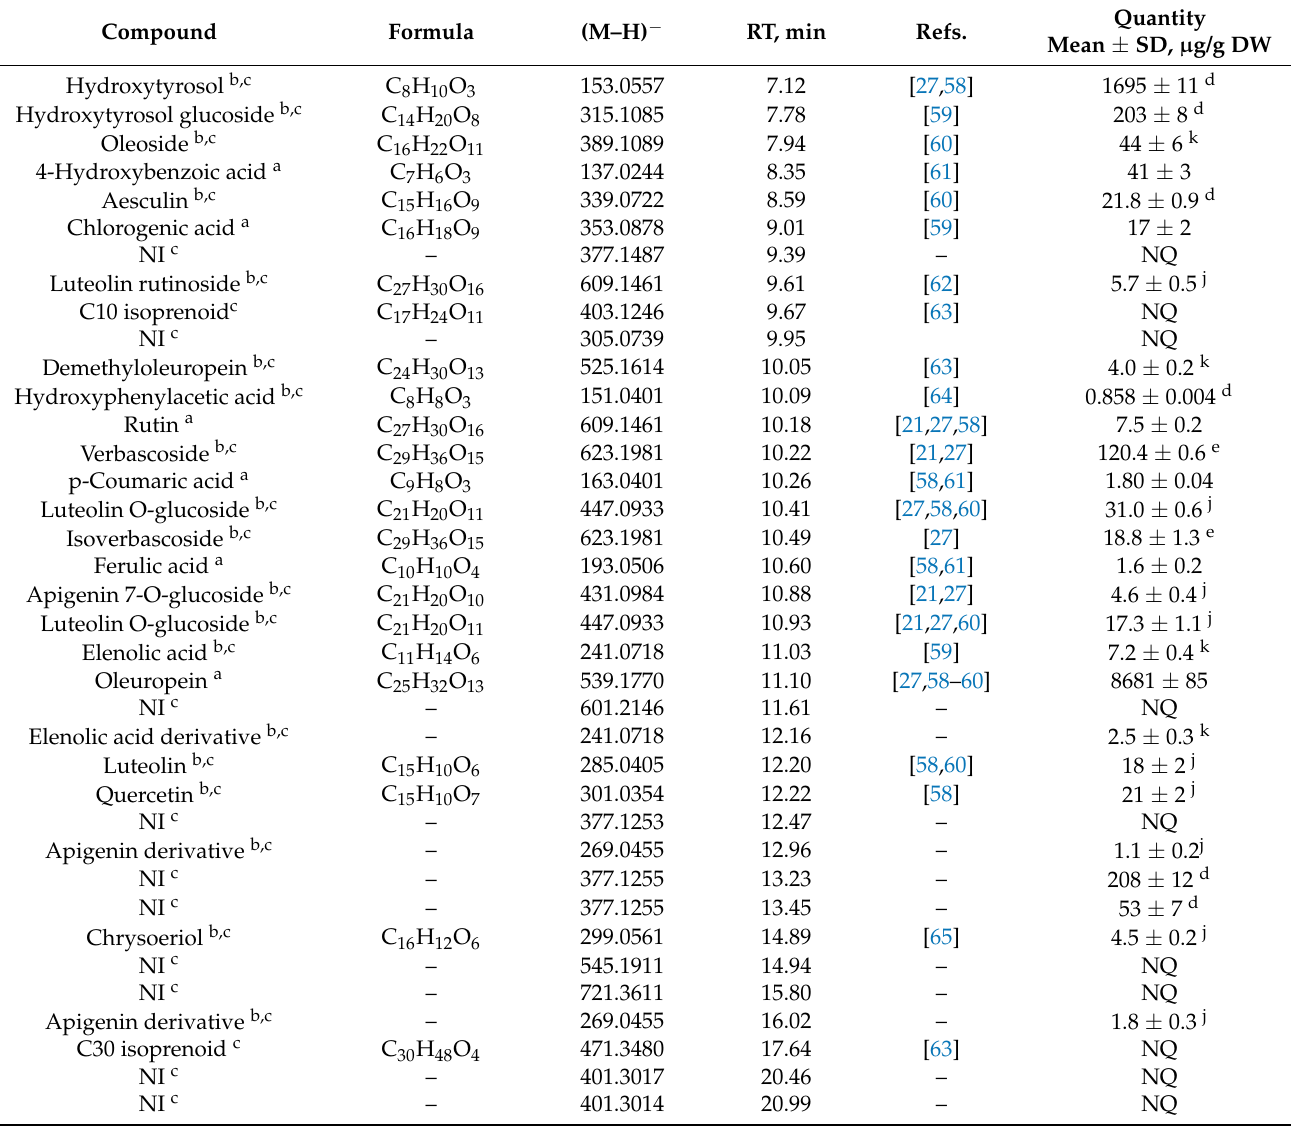
Table 2. Compounds identified in the Olea europaea leaf